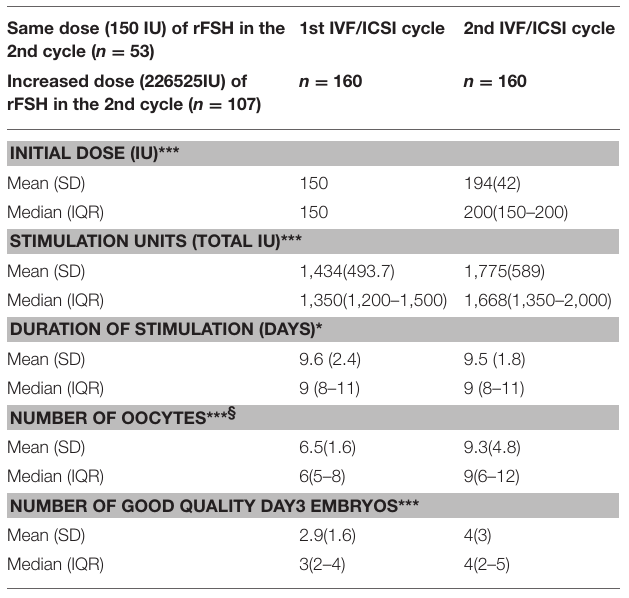
TABLE 2 | Ovarian stimulation outcomes.